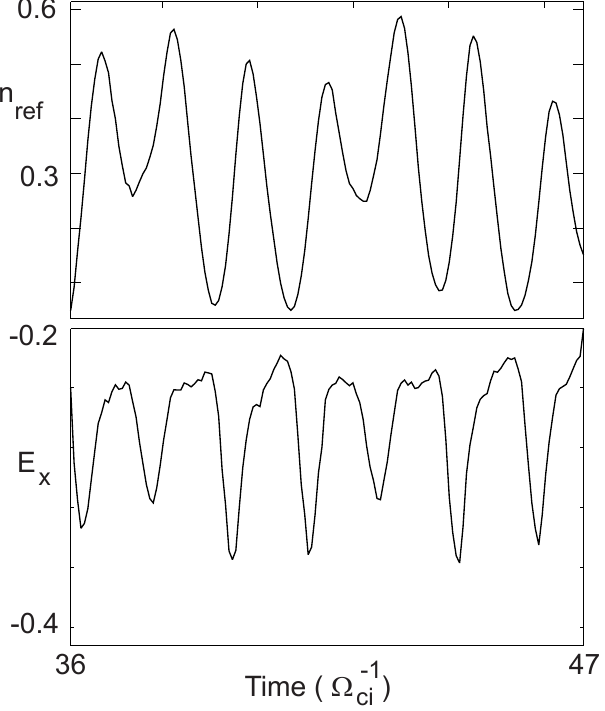
Fig. 11. Number of reflected ions within a distance of 50 λ e up- stream of the maximum of the cross shock potential.